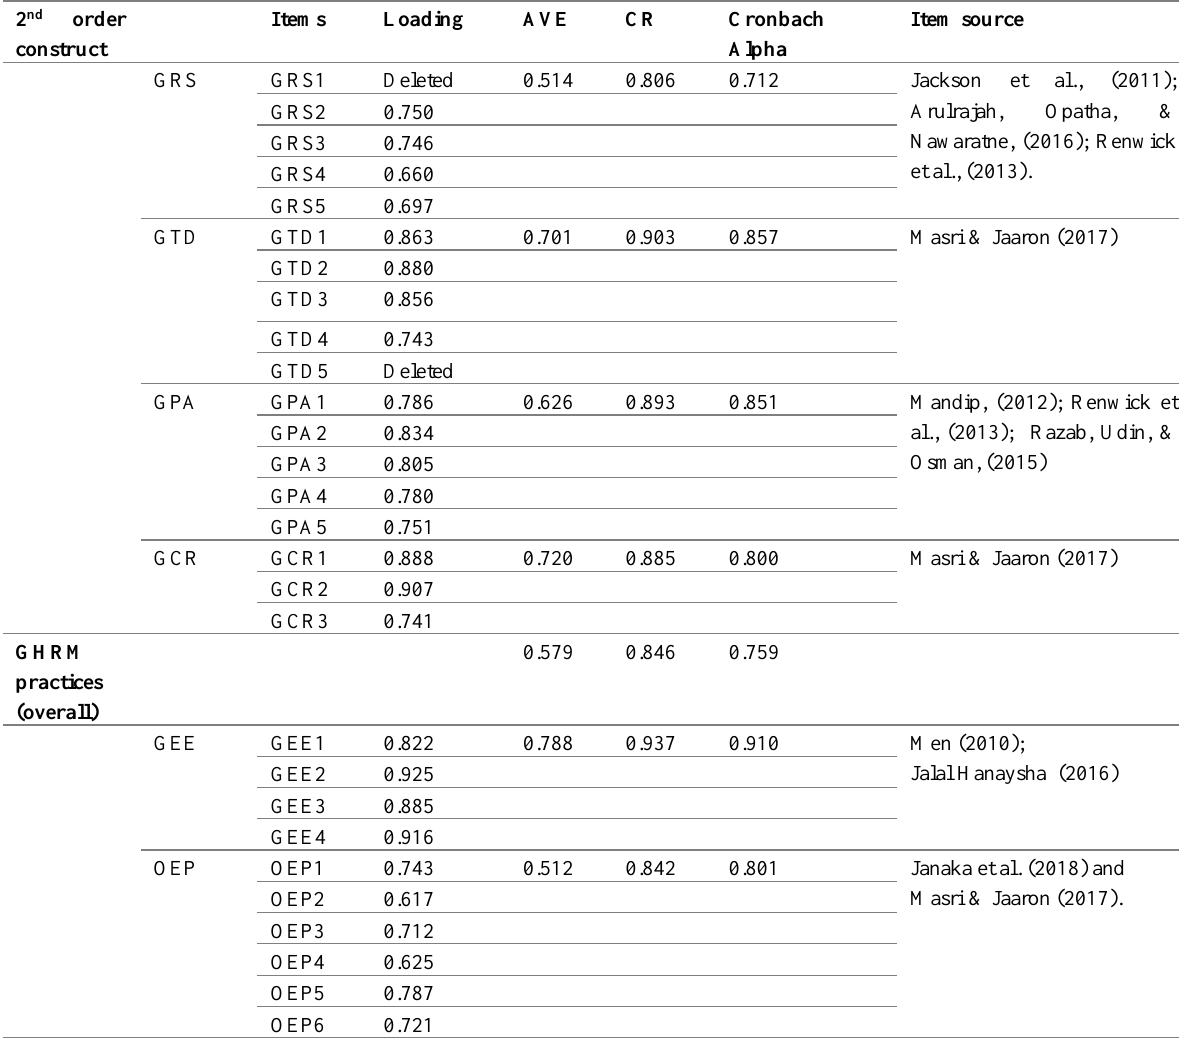
Table 1: Outer loading, CR, AVE and Cronbach